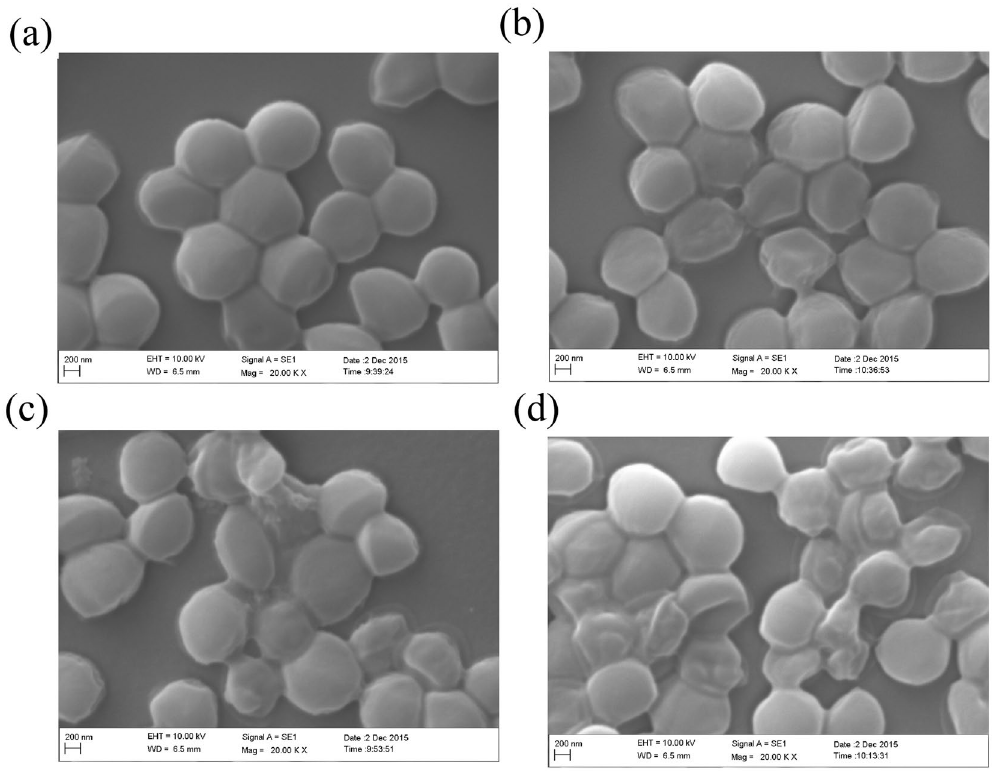
Figure 2. SEM images of untreated S. saprophyticus P2 cells ( a ), as well as cells treated with nisin ( b ), SlpB ( c ), and nisin plus SlpB ( d ). Nisin concentration, 100 μ g/mL; SlpB concentration, 40 μ